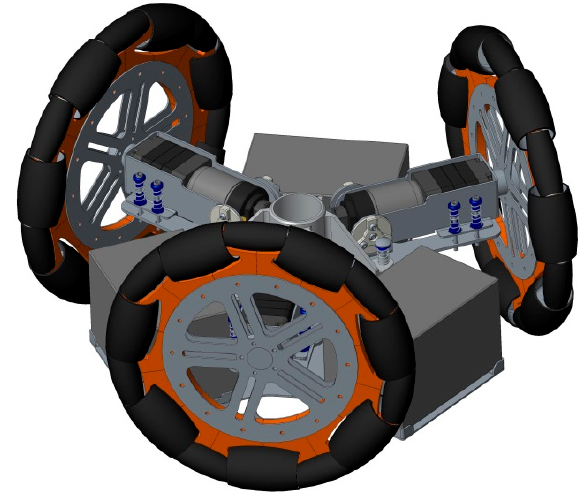
Figure 3. CAD model of the motion system based on the use of three omnidirectional wheels shifted 120°.